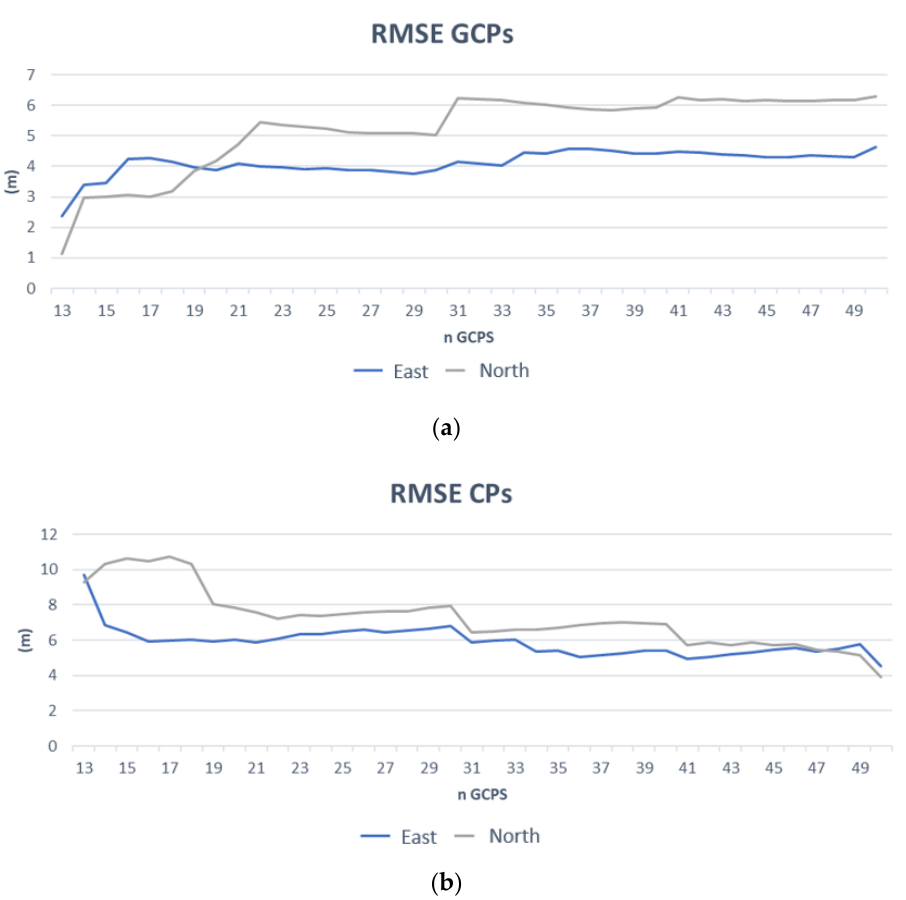
Figure 13. Trend of precision ( a ) and accuracy ( b ) in relation to the number of collimated GCPs, referred to the Fucino test field.